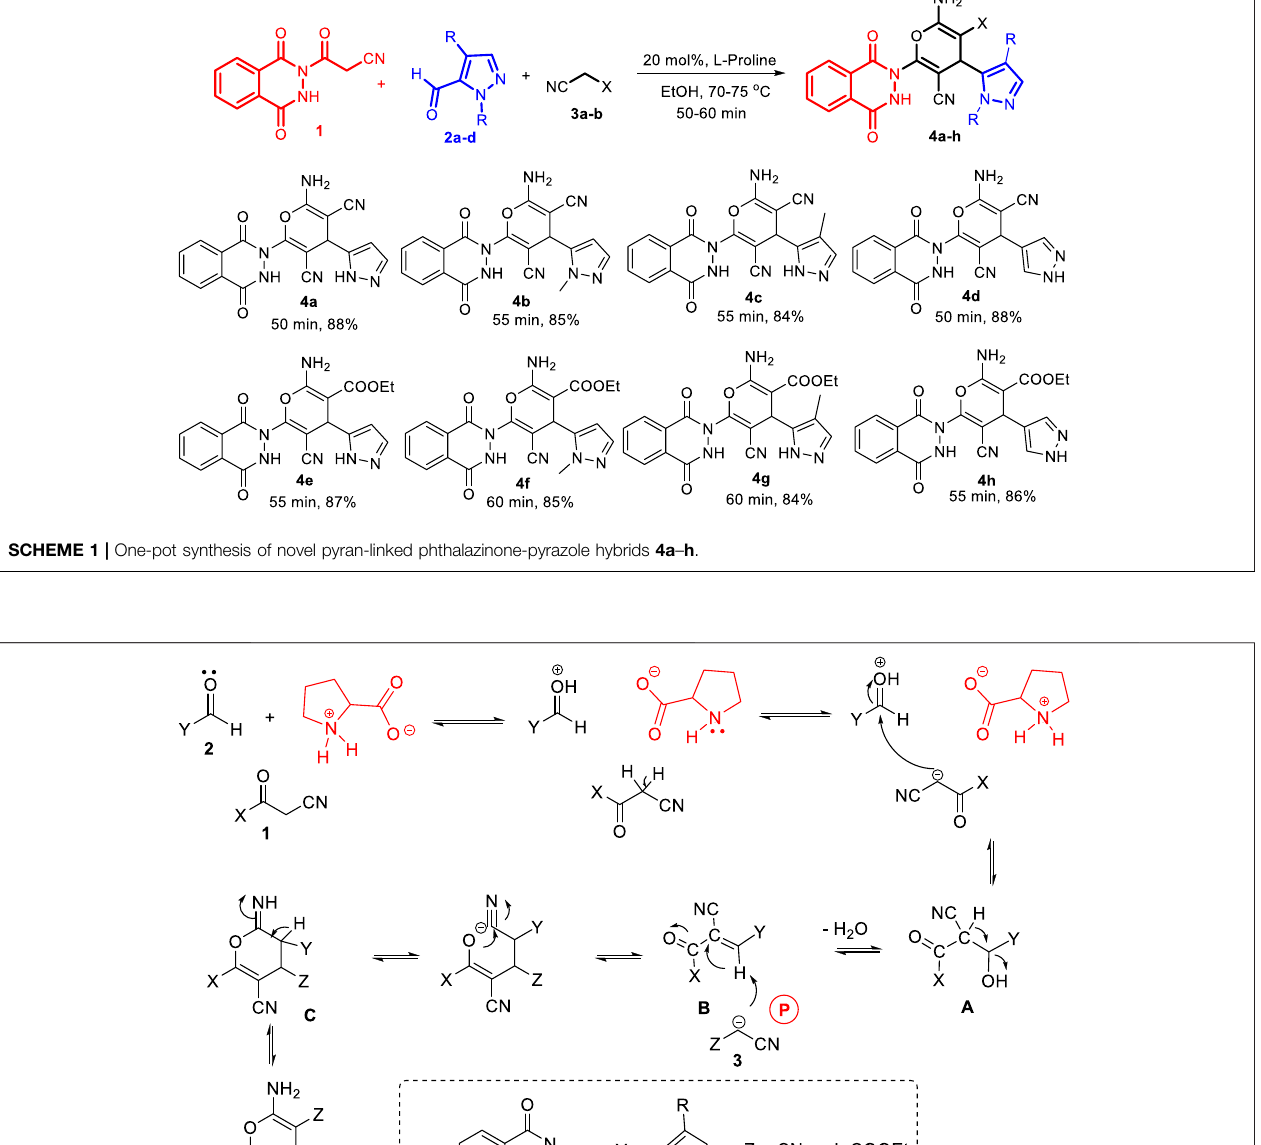
Frontiers in Chemistry |